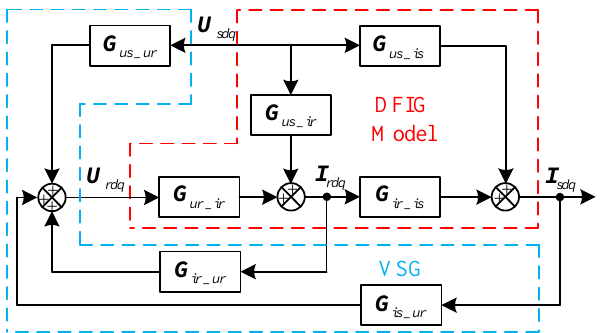
Figure 4. Block diagram of small signal transfer matrices for VSG control in synchronous dq -frame.